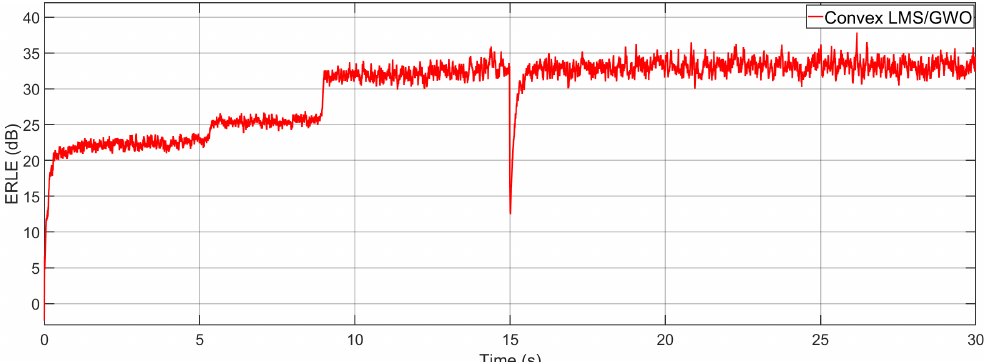
Figure 15. ERLE learning curve of the proposed convex GWO/LMS considering a speech sequence signal as input signal.